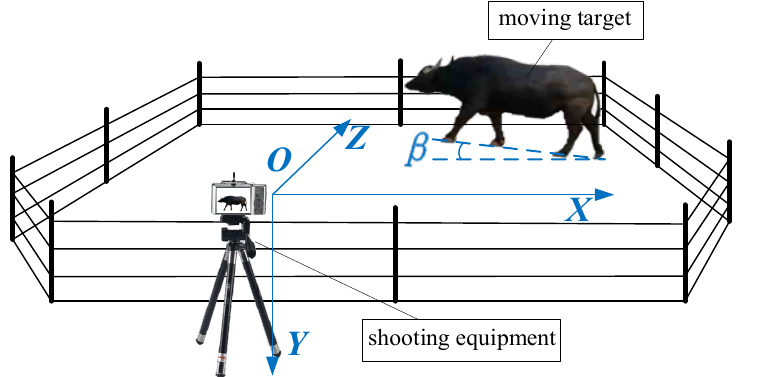
Figure 12. Quadruped animal video capture system in our study.